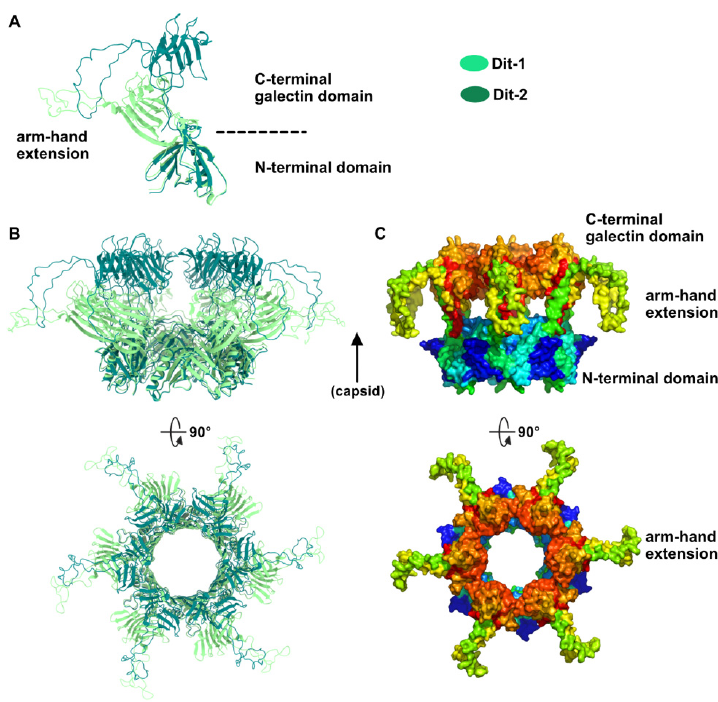
Figure 3. Dit structures. ( A ) Ribbon representation of superimposed Dit-1 monomer crystal structure (PDB ID 2WZP) and Dit-2 monomer model. The color code is indicated. ( B ) Ribbon representation of superimposed Dit-1 hexamer crystal structure and Dit-2 hexamer model (orthogonal views). ( C ) Surface representation of the hexameric Dit-2 model (orthogonal views). The rainbow coloring mode highlights the Dit-2 N-terminal bottom ring (blue) and the C-terminal galectin top ring (red) including the arm-hand extension (green and